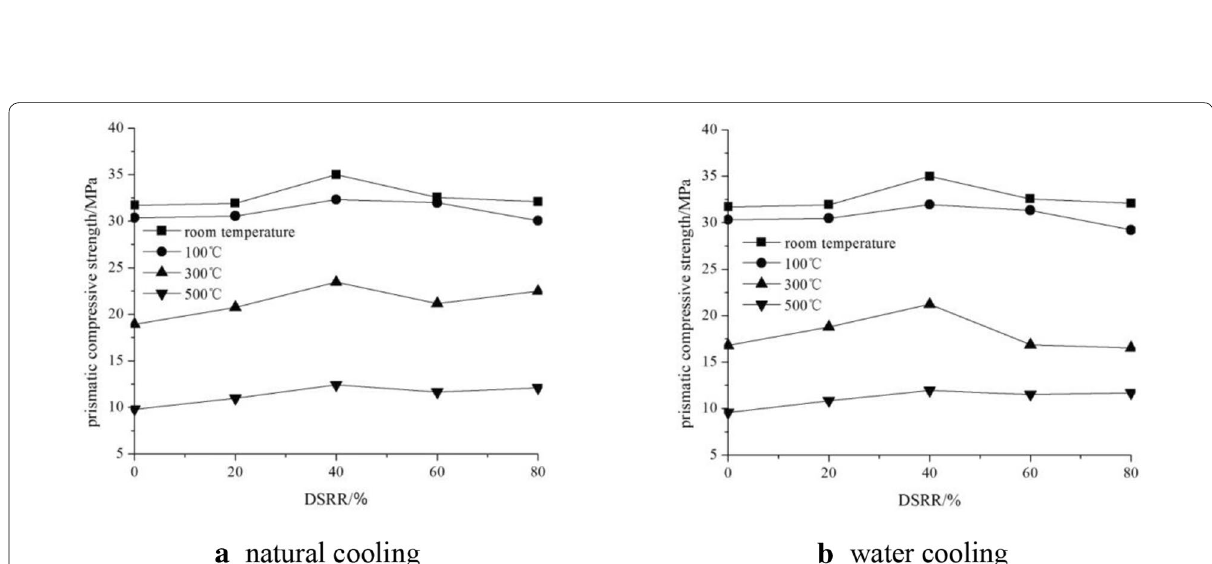
Fig. 11 Relation between the prismatic compressive strength of concrete produced with desert sand and